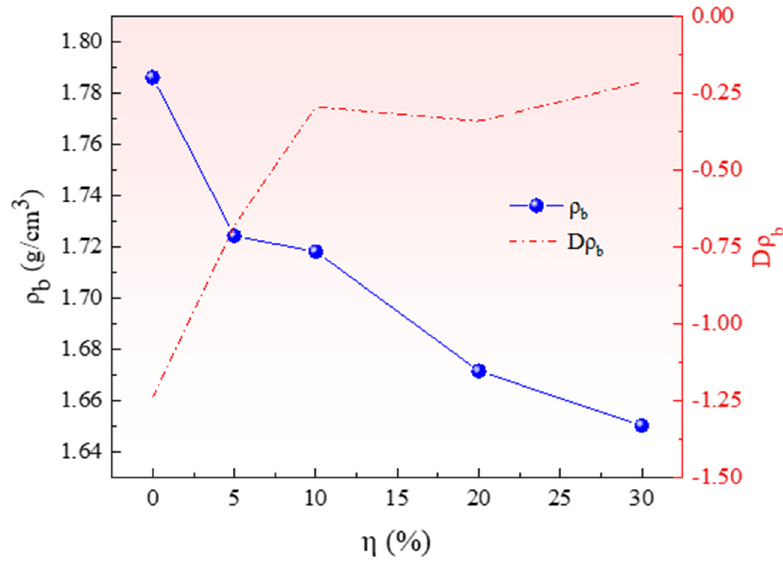
Figure 4. Relationship between pellet density and ratio of pore-forming agent.